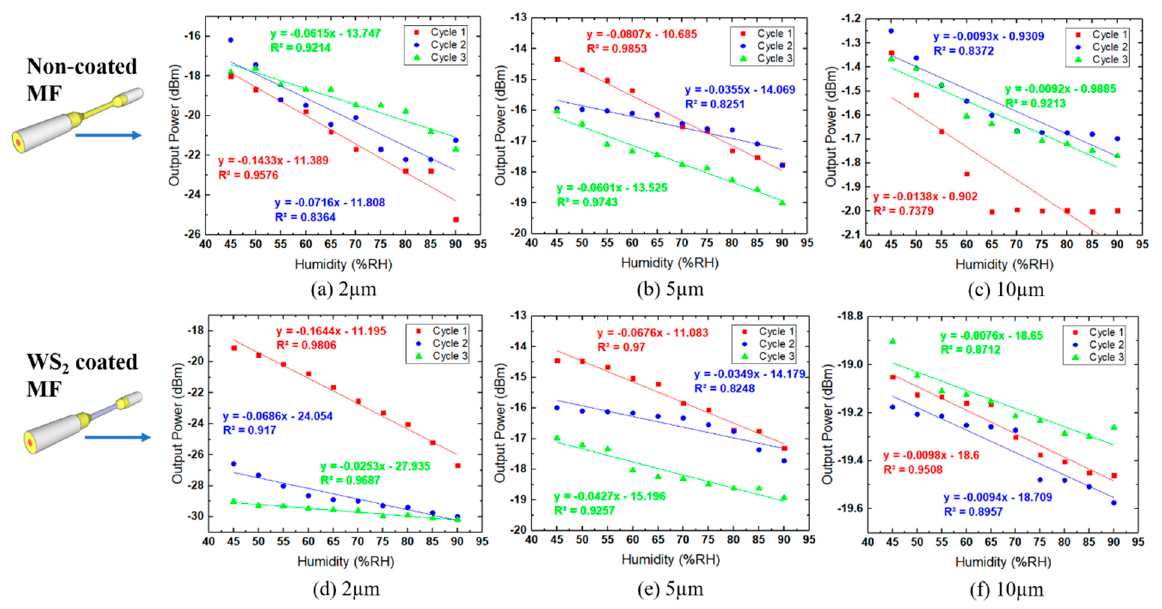
Figure 9. Non-coated MF ( a – c ) and coated MF ( d – f ) of 2, 5, and 10 µ m repeatability results with different levels of humid- ity.